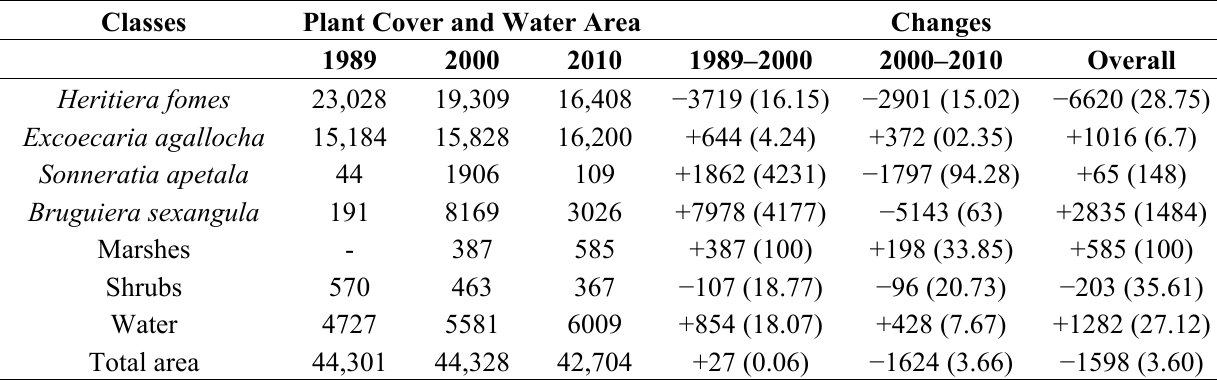
Table 1. Changes (in ha) of forest cover, marsh and water area from 1989 to 2000 and 2010, determined by GIS technique at Khulna and Chandpai ranges (one spot from each and together). Values within parentheses is percent